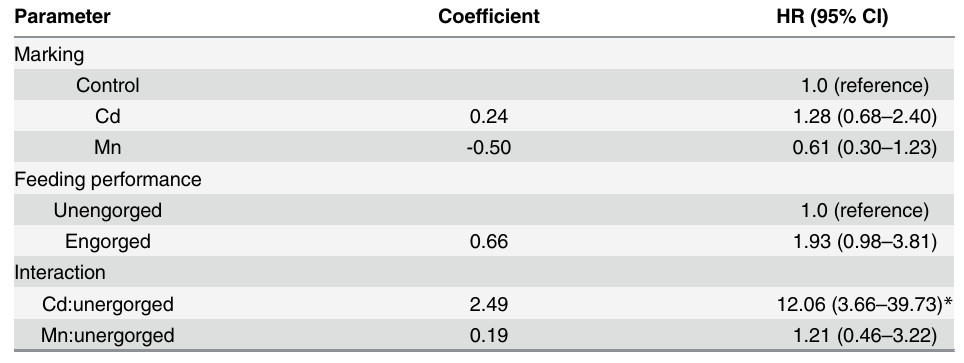
Table 5. Associations between Rhodnius nasutus trace element marking and feeding performance or